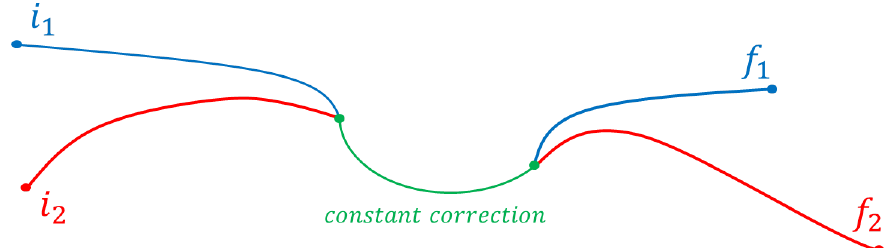
Figure 2. Proposed method to maintain the correction. i 1 and f 1 are the initial and final points of the trajectory where the user applied the manual correction (green line). i 2 and f 2 are the initial and final points of another trajectory that is encoded using the same sets of DMPs but keeping the correction constant in the